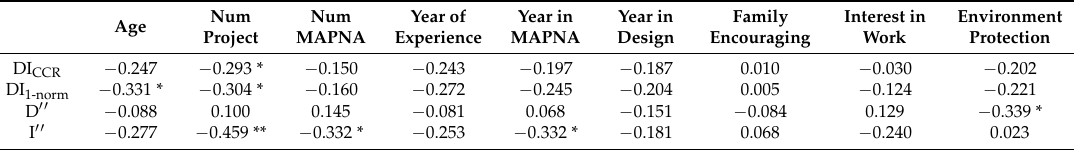
Table 5. Correlation coefficient between engineers’ leadership efficiency and engineers’ demographic. Num Num Year of Year in Year in Family Interest in Environment Age Project MAPNA Experience MAPNA Design Encouraging Work Protection DI CCR − 0.181 − 0.240